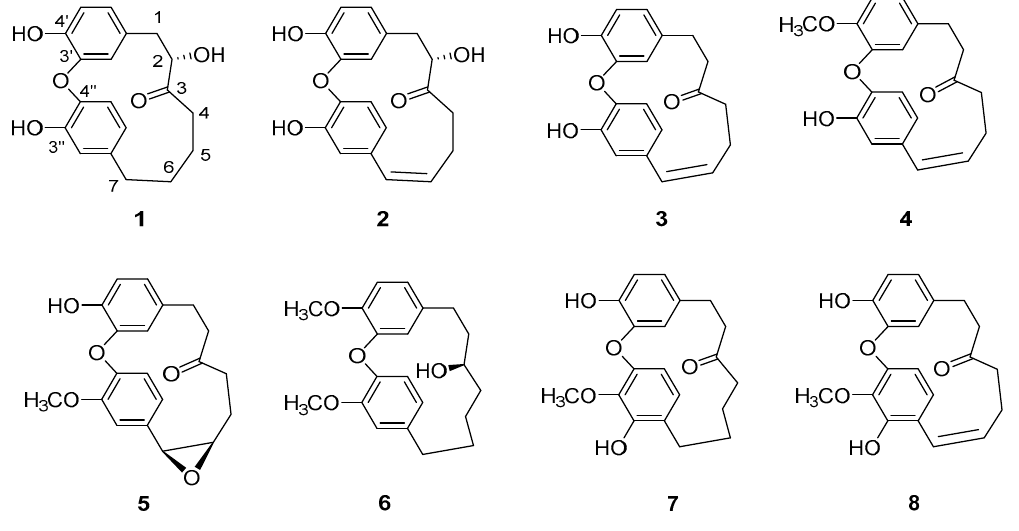
Figure 1. Structures of compounds 1 – 8 .